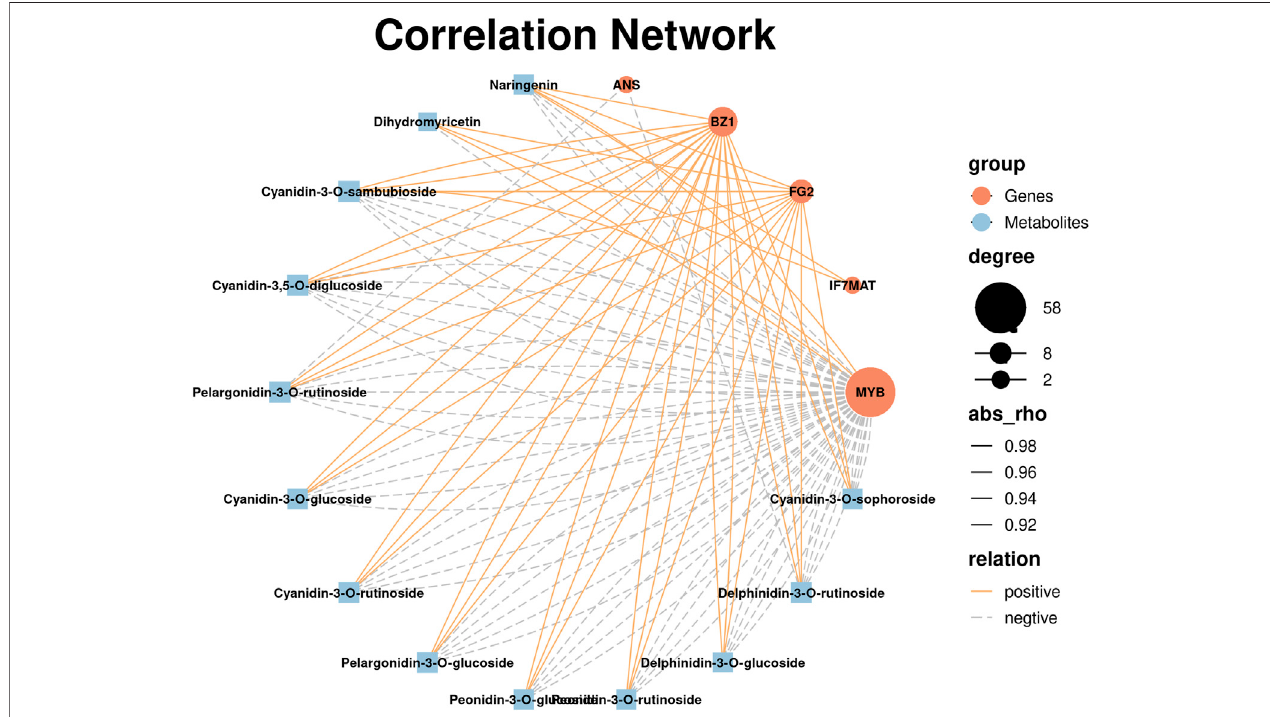
FIGURE 5 | The construction of regulatory network between DEGs and DAMs. rho represents the Pearson correlation coef fi cient ( r ). Degree represents the gene number. Relation represents the correlations with a coef fi cient ( r ) value > 0.9 (positive) or < − 0.9 (negative).